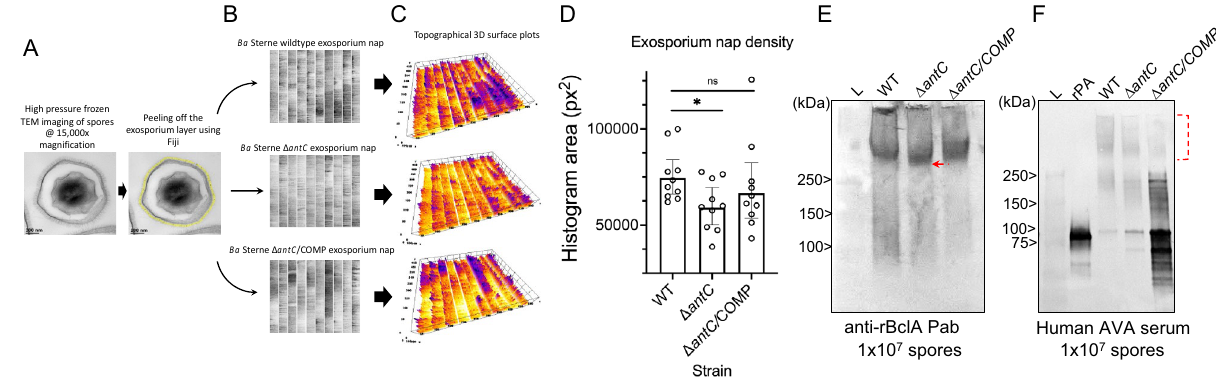
Figure 2. Analysis of the exosporium by fiber topographical surface plot and western blot. ( A ) An example of a single spore image that was analyzed using Fiji to ‘peel’ the exosporium nap layer from the spore surface. ( B ) Ten randomly selected B. anthracis Sterne WT, Δ antC , Δ antC /COMP spores had their exosporium nap arrayed. ( C ) These same ten spores had their nap layers converted to a topographical 3D surface plot to ease visualization of the electron density associated with the TEM images. ( D ) The black and white images in ( B ) were converted to histograms and their areas determined. * p < 0.05; ns = not significant. Individual values, averages and 95% CI are shown. ( E ) Polyclonal Ab to rBclA was used to blot 1 × 10 7 purified spores of each strain. The red arrow indicates a slight decrease in molecular weight associated with deletion of anthrose. ( F ) The same spore preps in ( E ) were blotted against pooled human AVA serum, indicating immune reactivity to spore antigen. High molecular weight regions coinciding with BclA reactivity in ( E ) are indicated by the dashed